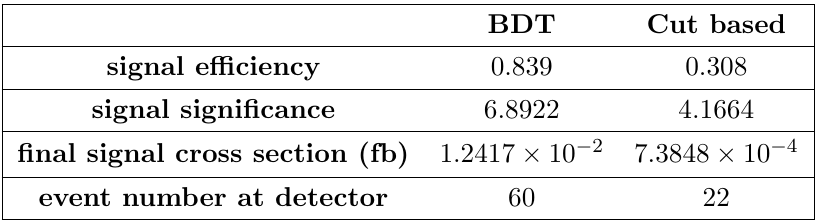
Table 7 . Comparison between BDT and cut-(cid:13)ow based results at L = 30 ab (cid:0) 1 for pp ! H (cid:6)(cid:6) H (cid:7) ! ‘ (cid:6) ‘ (cid:6) hW (cid:7) .